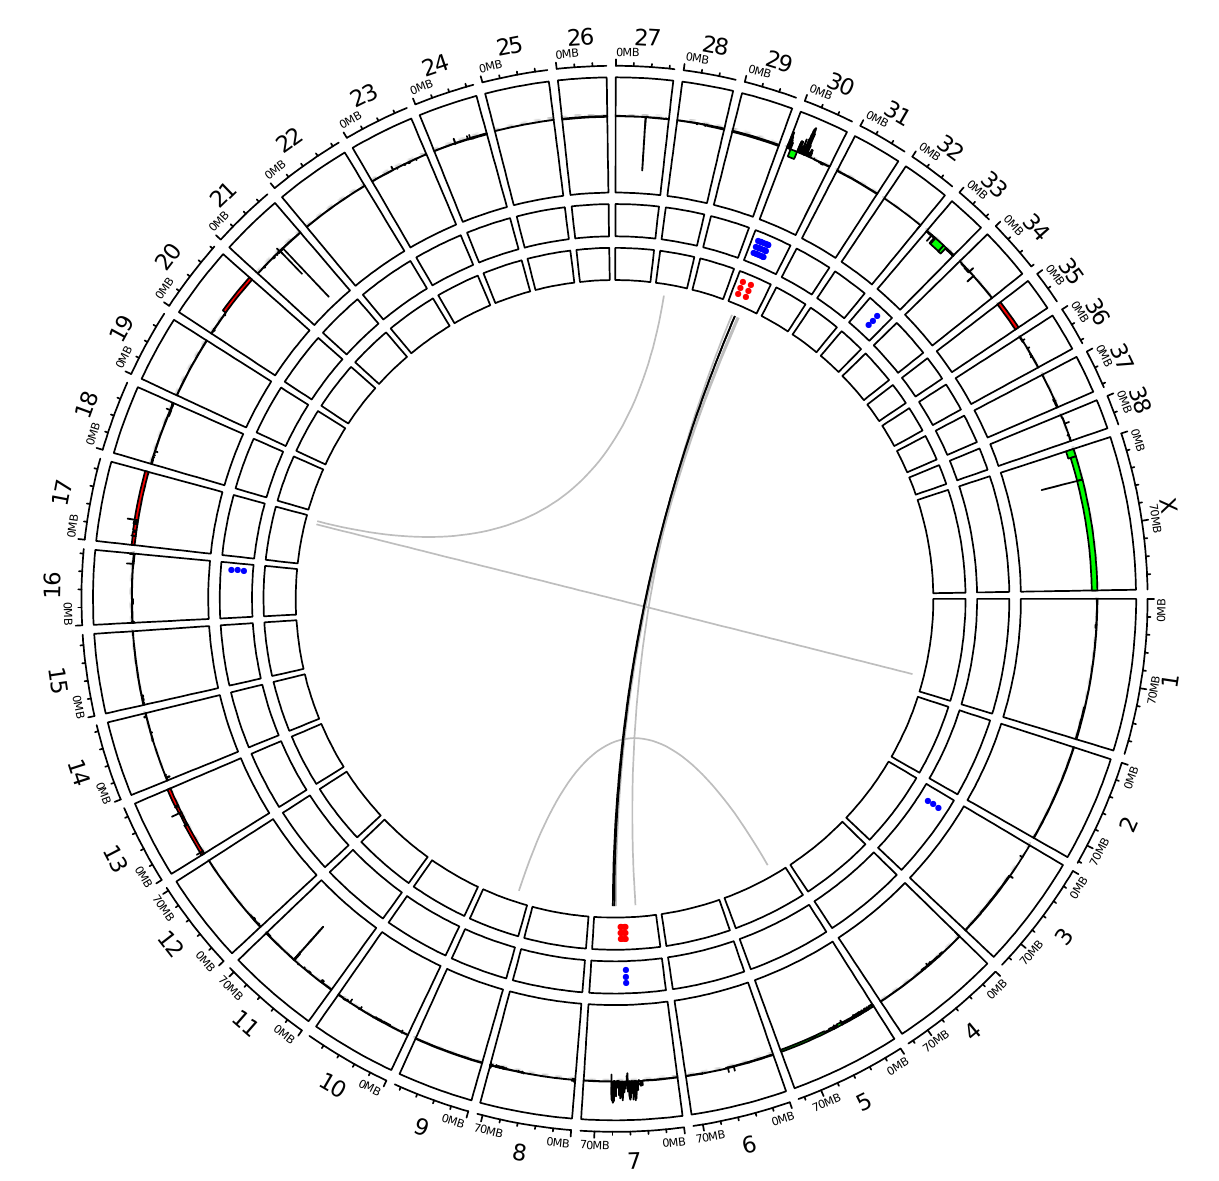
Figure A4. Circos plot representing the distribution of SVs of Dog-OralMel-18333 cell line along dog chromosomes with, from external to internal layers, CNA gains/losses (in dark red/green), deletions, duplications, insertions, and inversions in blue, light red, orange, and green, respectively. Interchromosomal break-ends (BND) are represented by gray lines connecting chromosomes with a color intensity corresponding to the number of reads validating the SV.